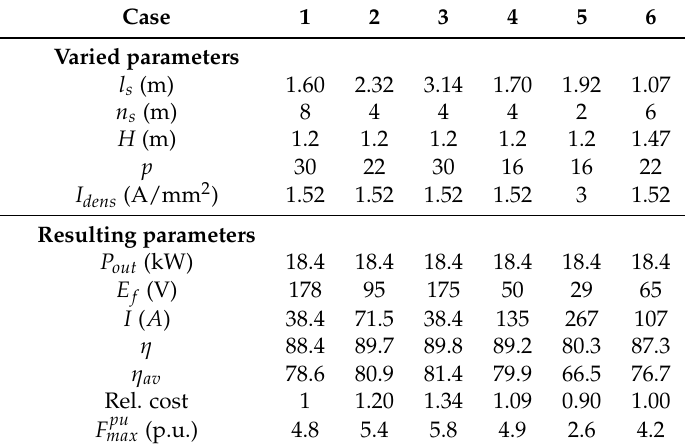
Table 2. Comparison of six different